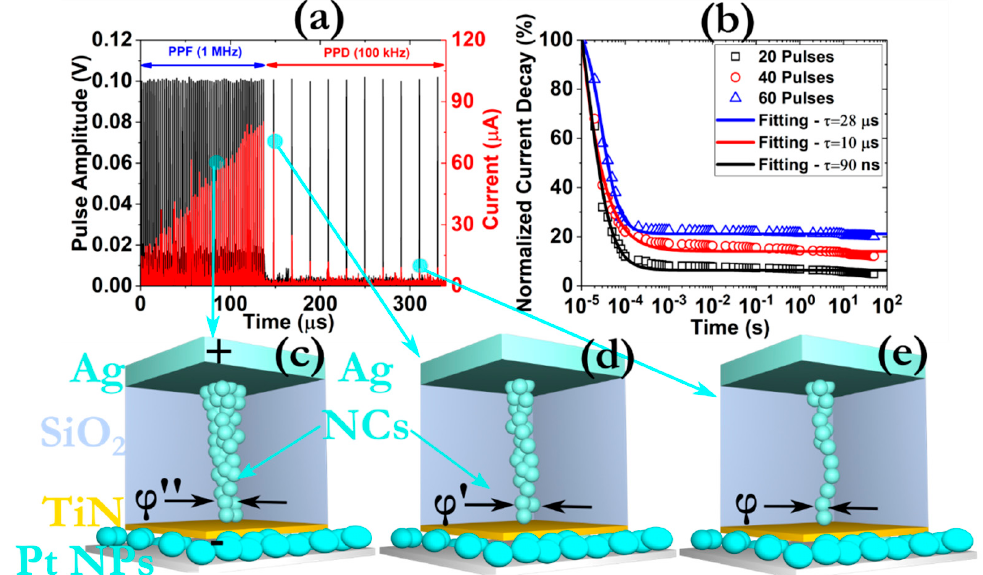
Figure 7. ( a ) Experimental verification of the PPF to paired-pulse depression (PPD) transition effect by monitoring the post-synaptic current response after the application of a train of 70 pulses with the same width (100 ns), amplitude (0.5 V) and different frequency; ( b ) normalized current decay distribution as a function of time demonstrating STP synaptic behavior. The data were collected after applying a set of 95 pulses, with a frequency of 100 kHz, after the enforcement of 60 pulses, with frequency 1 MHz; ( c – e ) schematic representation of the CF growth procedure during the application of the consecutive pulsing scheme. The symbol ϕ stands for the effective diameter of the